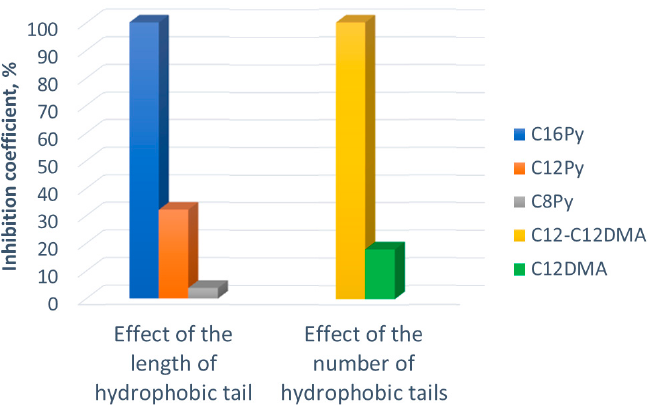
Figure 2. Effects of hydrophobicity on the virucidal activity of cationic surfactants against SARS-CoV-2: ( left ) effect of the length of the hydrophobic tail (for C8Py, C12Py, and C16Py surfactants having the same hydrophilic pyridinium head group) and ( right ) effect of the number of hydrophobic tails (for C12DMA and C12-C12DMA surfactants) on the values of the inhibition coefficient, observed at 0.28 mM concentration of each surfactant.